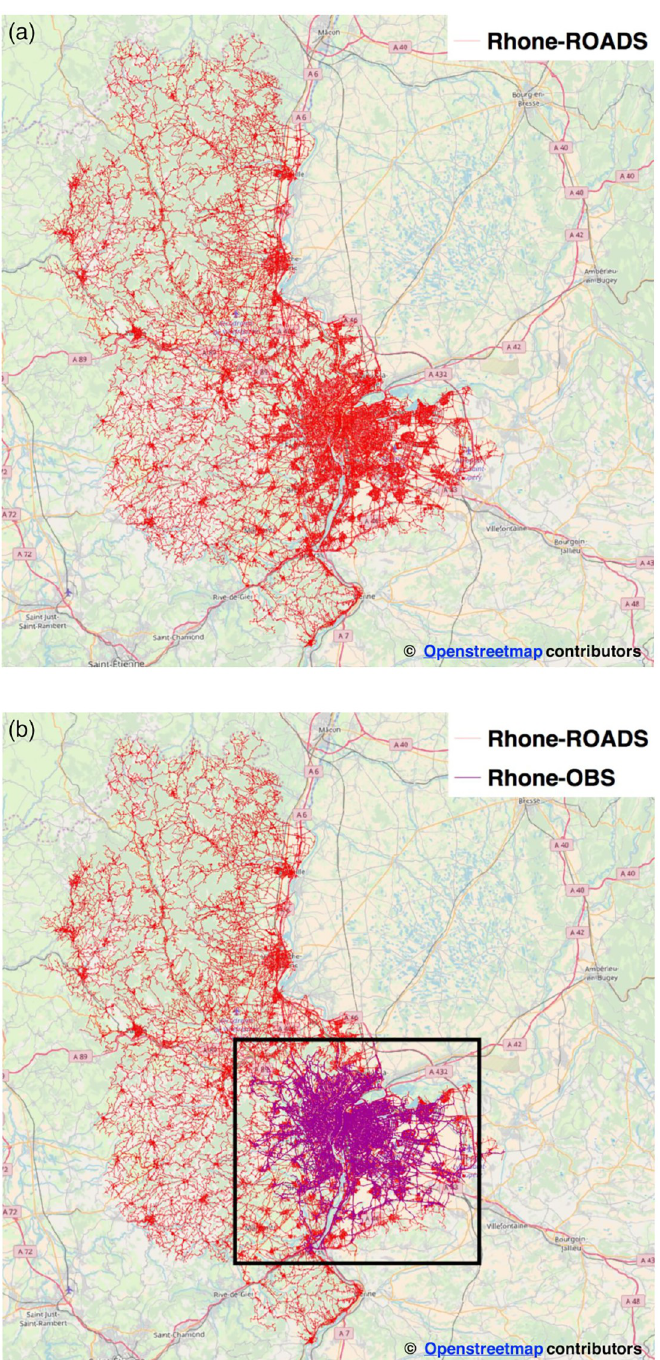
Fig 1. The Rhone-department road network. Maps throughout this research article were created using open-source data from OpenStreetMap and OpenStreetMap Foundation, which is made available under the Open Database Licence. Map tiles are from OpenStreetMap cartography, which is licensed as CC BY-SA (see https://www. openstreetmap.org/copyright). (a) Rhone-ROADS: the Rhone-department network, graphically shown as an undirected and unweighted graph (b) Rhone-OBS: The Rhone-department sub-network shown on top of the Rhone- ROADS. The graph only includes edges with at least one observed elementary taxi trip (in purple).